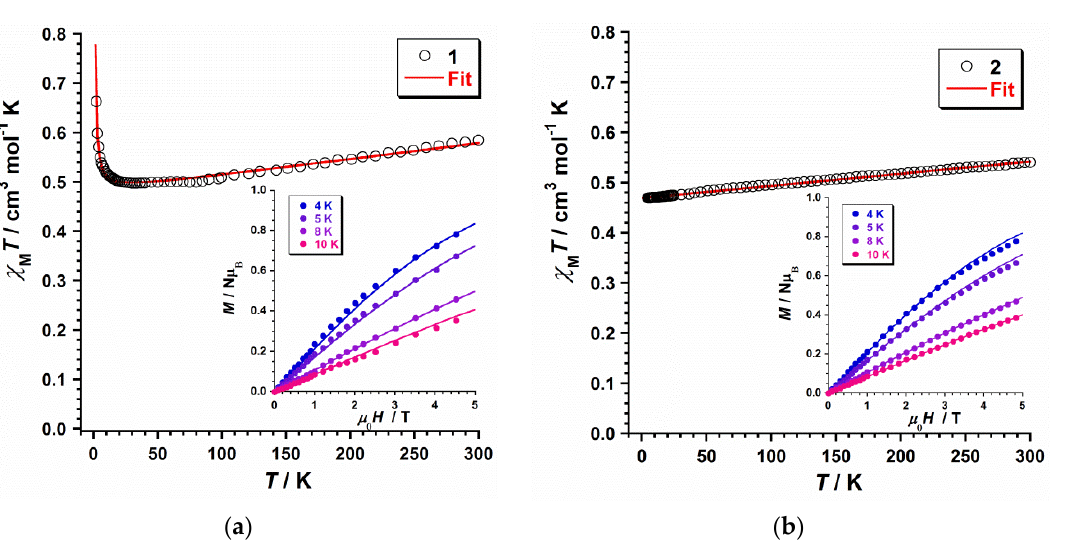
Figure 6. ( a ) Plot of χ M T vs. T obtained for compound 1 , the solid red line being the best fit. The inset displays the M versus H plot for 1 ; ( b ) Plot of χ M T vs. T obtained for compound 2 , the solid red line being the best fit. The inset displays the M versus H plot for 2 .